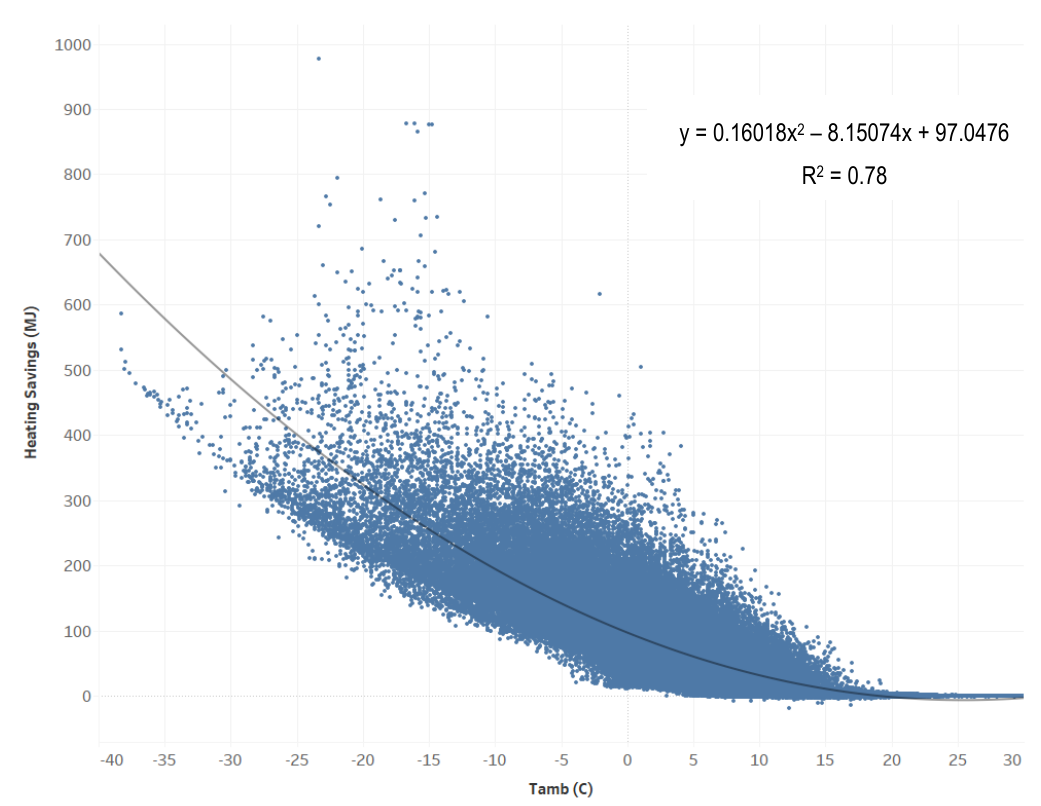
Figure 5. Heating savings as a function of outdoor temperature for the combined 35 cities in climate zones 4 and 8 that are listed in Table 1. Table 3. Models for hourly heating energy savings in climate zones 4–8, annual heating energy savings results for representative cities, and percent error from comparison to values from the calculator. Climate